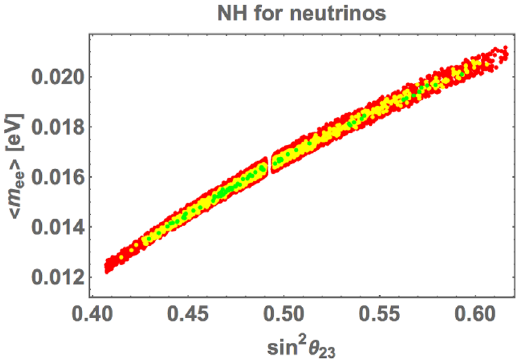
Figure 5 . Predicted Majorana phases α 21 and α 31 for NH. Colors denote same ones in figure 1.